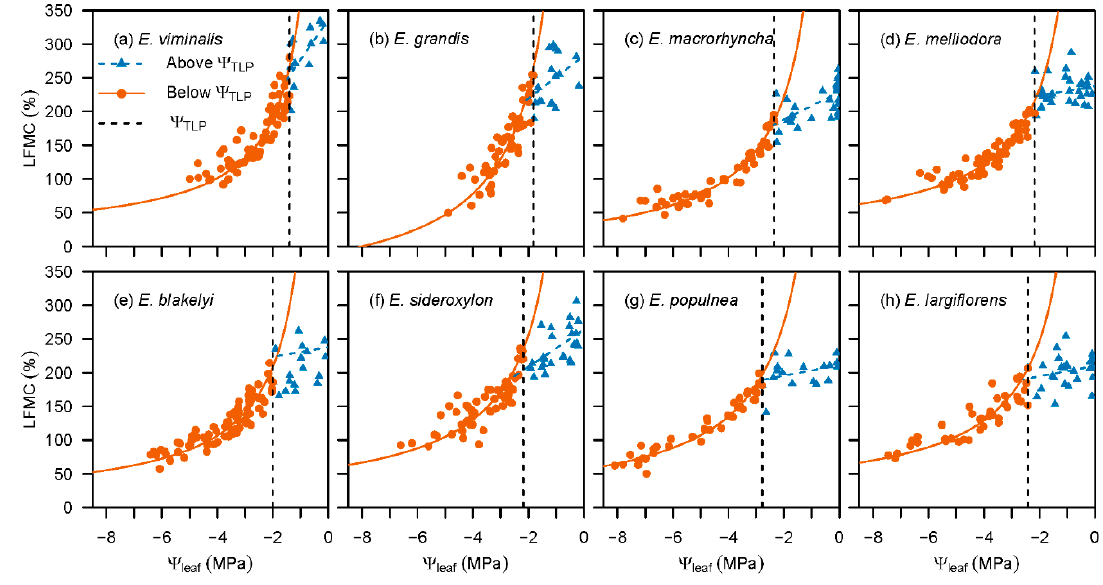
Figure 3. Decline in LFMC and Ψ leaf modelled using Equation (3) (for data > Ψ TLP ) and Equation (4) (for data < Ψ TLP : − 1 / Ψ leaf versus LFMC), for saplings of eight Eucalyptus species. Species are ordered by increasing moisture index (ratio of precipitation to potential evapotranspiration) from climate of origin, i.e., E. largiflorens is from the most arid climate. Regressions for all species were statistically significant ( p < 0.05), except the slope of the linear regression above the Ψ TLP for the following species: E. grandis , E. melliodora , E. blakelyi , E. populnea and E. largiflorens . (a) E. viminalis; (b) E. grandis; (c) E. macrorhyncha; (d) E. melliodora; (e) E. blakelyi; (f) E. sideroxylon; (g) E. populnea; (h) E. largiflorens.